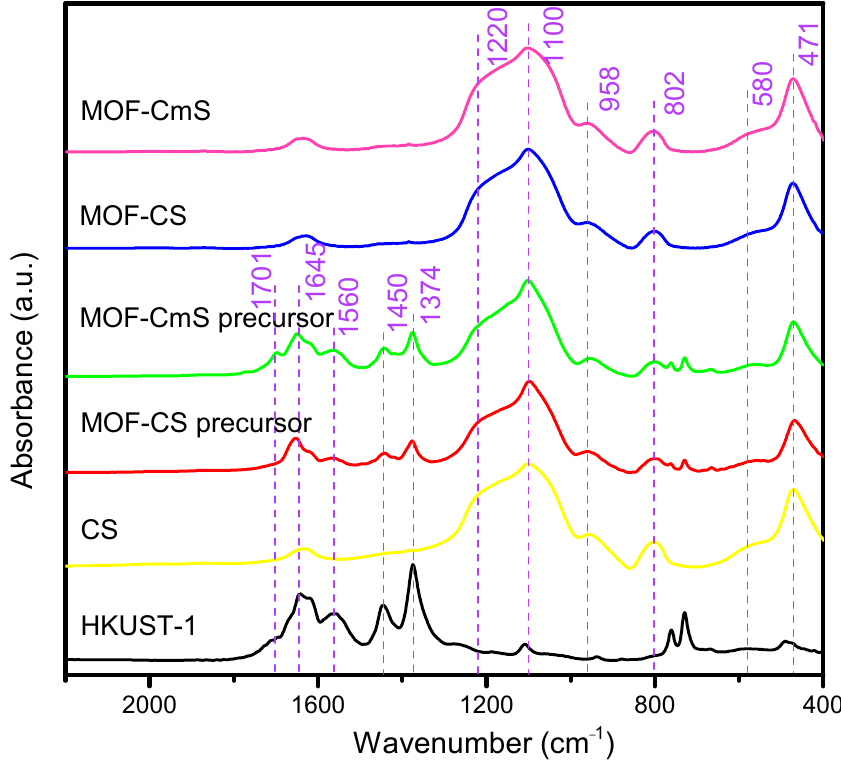
Figure 3. FT ‐ IR spectra of HKUST ‐ 1, CS, and Cu/SiO 2 samples and their precursors . Figure 3. FT-IR spectra of HKUST-1, CS, and Cu/SiO 2 samples and their